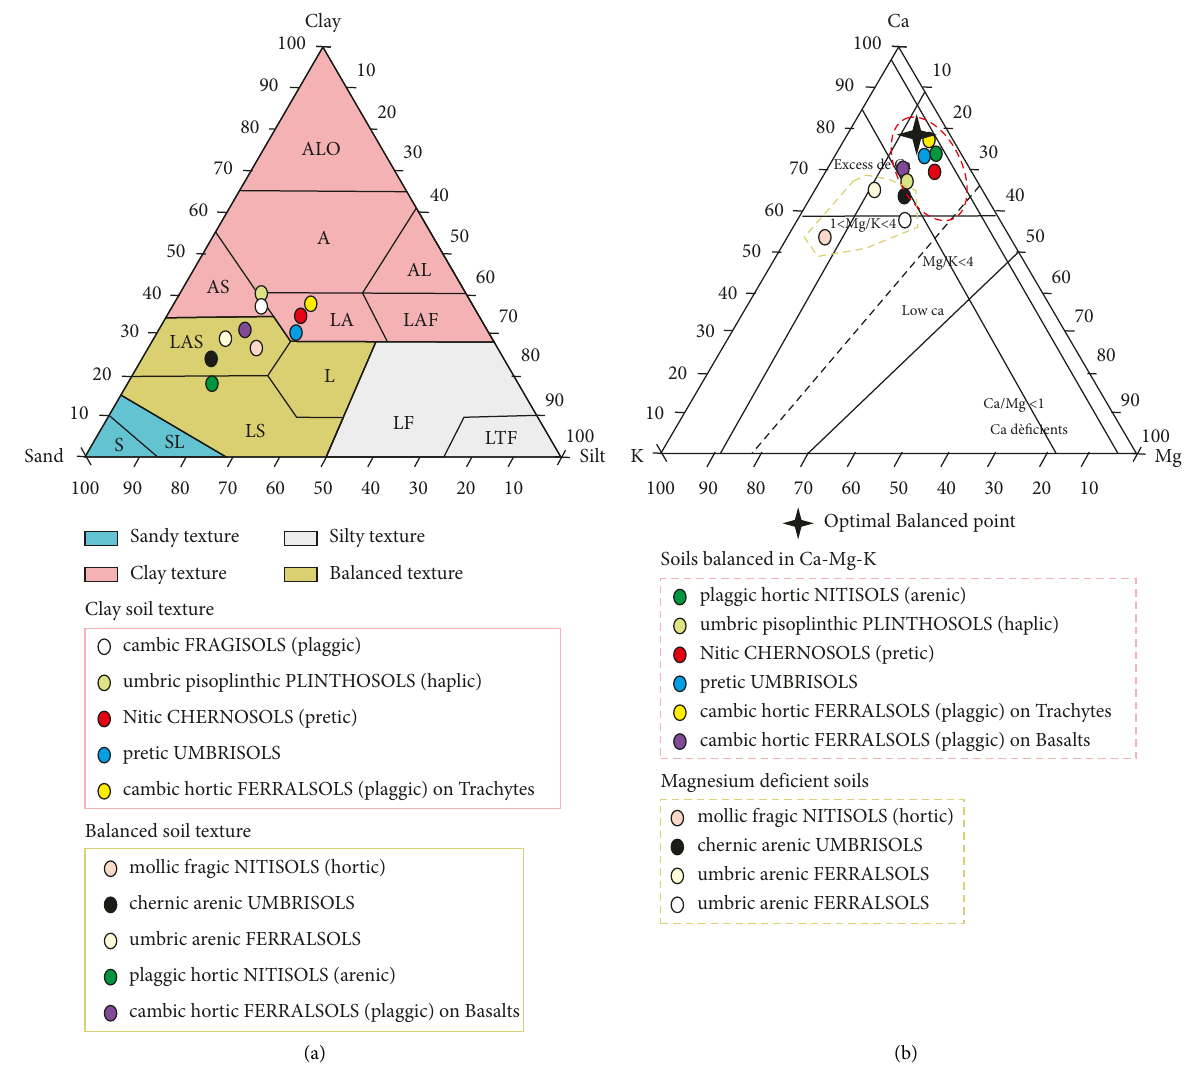
Figure 5: Textural and chemical classification of Foumban soils. (a) Textural diagram [53] and (b) global equilibrium Ca-Mg-K